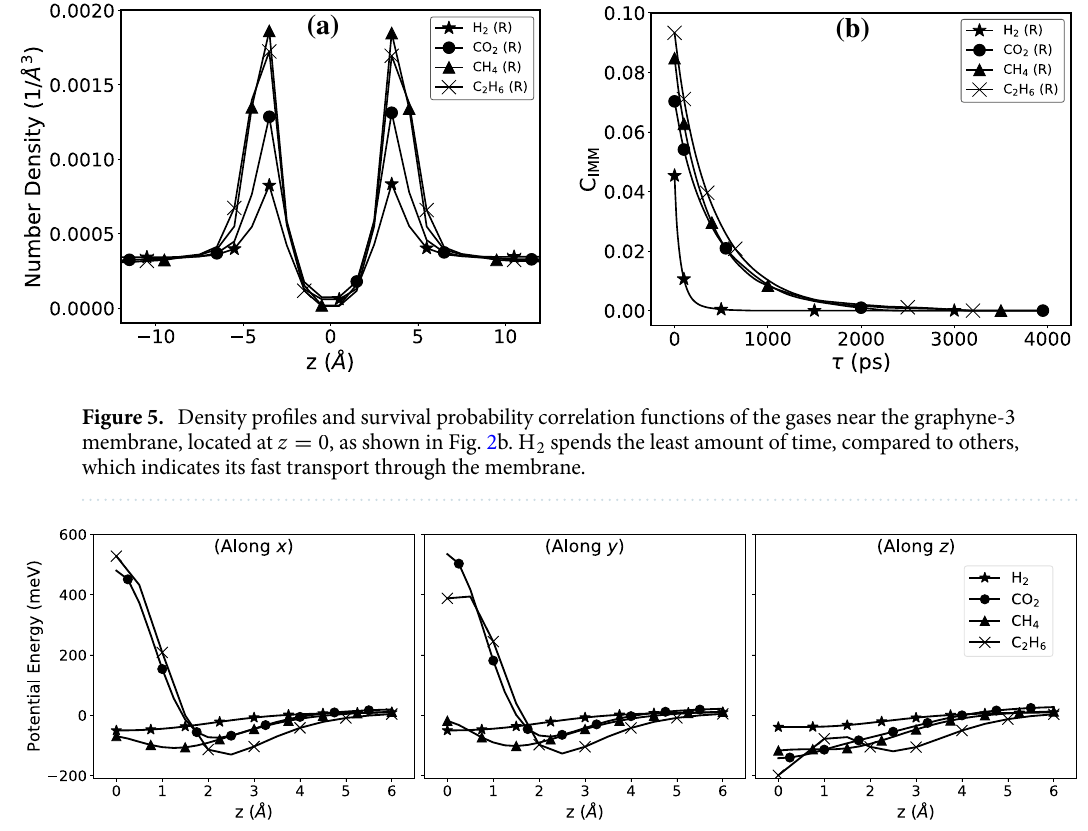
Figure 6. The potential energy surface of the various gases as a function of the distance from graphyne-3 membrane. The DFT method was used for the calculations. We considered three orientations of the molecule (along x , y , and z ) and displace it along z direction (normal to the